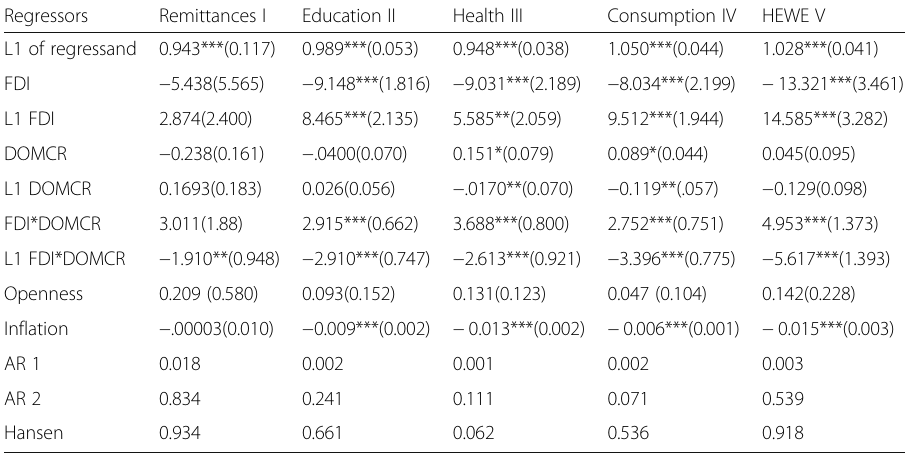
Table 9 FDI and domestic credit as proxies for foreign capital inflows and financial development